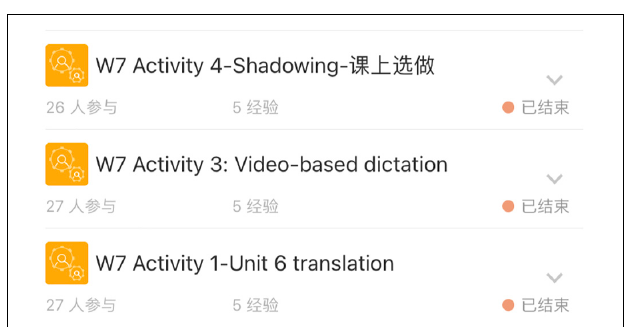
FIGURE 2 | An example of MosoTeach activities (week